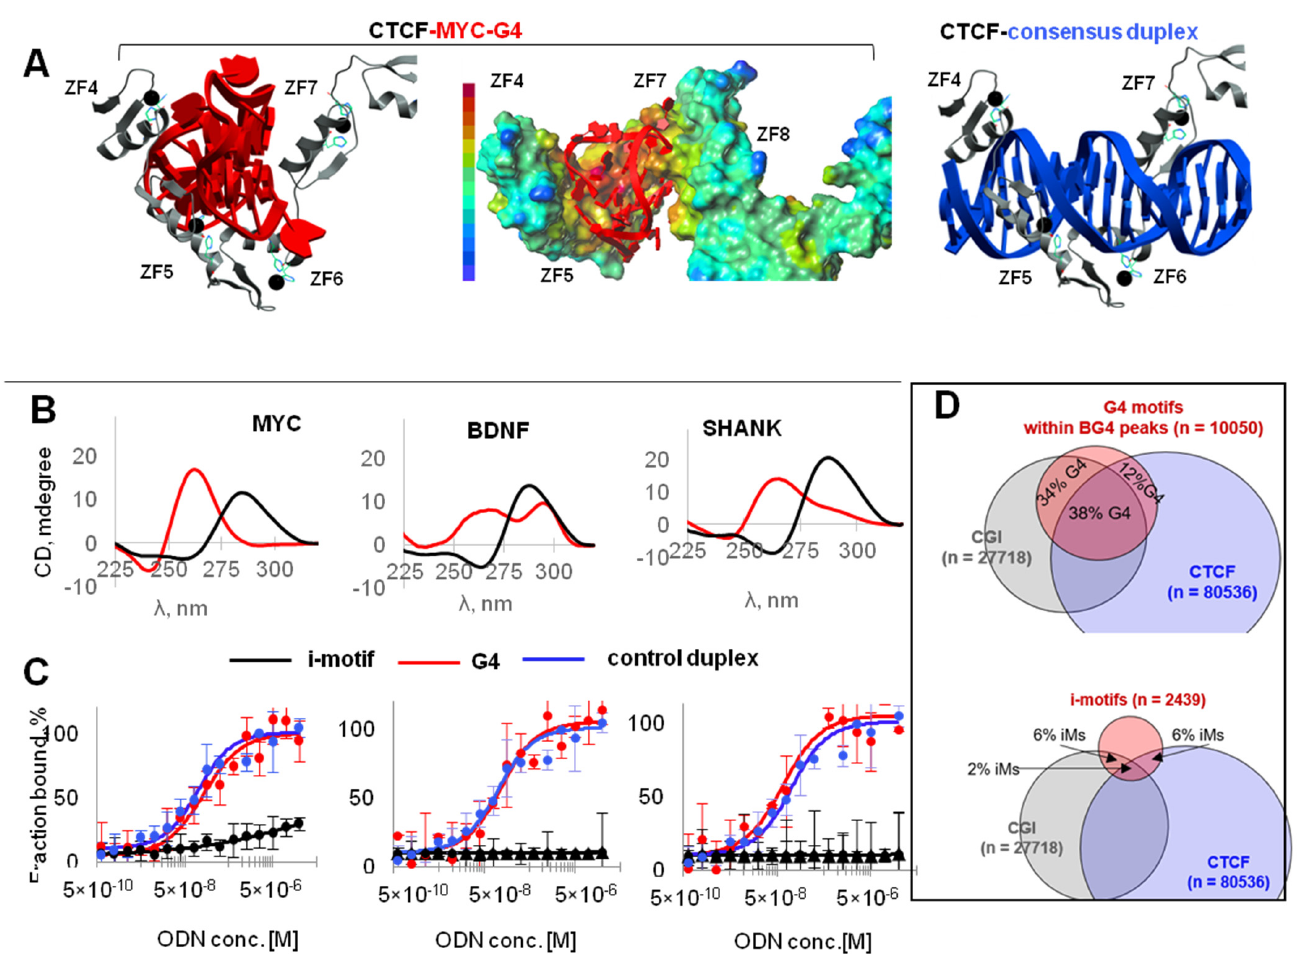
Figure 4. Analysis of CTCF-G4 interactions. ( A ) In silico verification of G4-CTCF binding. The best binding energy conformation of the complex obtained by docking MYC-G4 (red) to CTCF is shown. The complex with the consensus duplex (blue) is shown for comparison. In the middle panel, the surface of MYC-G4-bound CTCF is colored according to the electrostatic potential: from negative (blue) to positive (red). ( B ) Circular dichroism spectra of the 2 µ M G4 (red) and iM (black) solutions in 140 mM potassium-phosphate buffer, pH 6.7, supplemented with 10 mM NaCl, obtained at 22 °C. ( C ) Microscale thermophoresis (MST)-based analysis of CTCF interactions the G4s (red), respective i-motifs (black) and the control duplexes (blue). ( D ) Comparison of G4 motif and i-motif intersections with CTCF-bound sites in K562 cells.